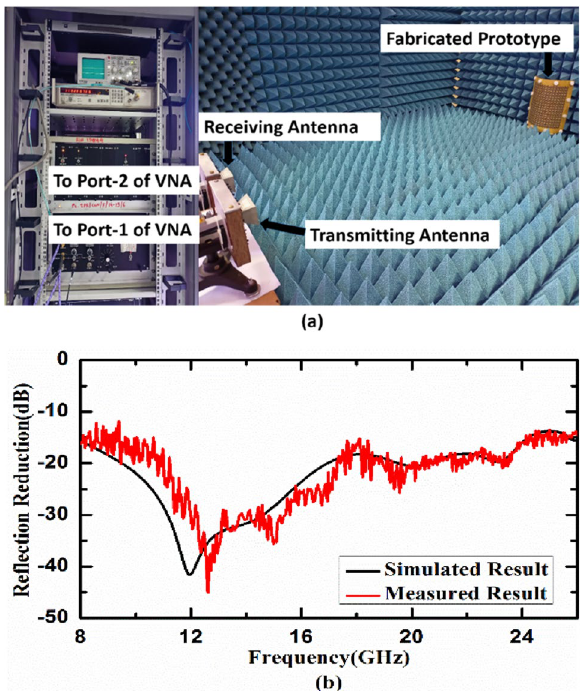
Figure 13. ( a ) Experimental setup for cylindrically bent surface with radius of curvature 130 mm and ( b ) simulated and measured reflection reduction of the developed cylindrically bent metasurface under normal incidence.